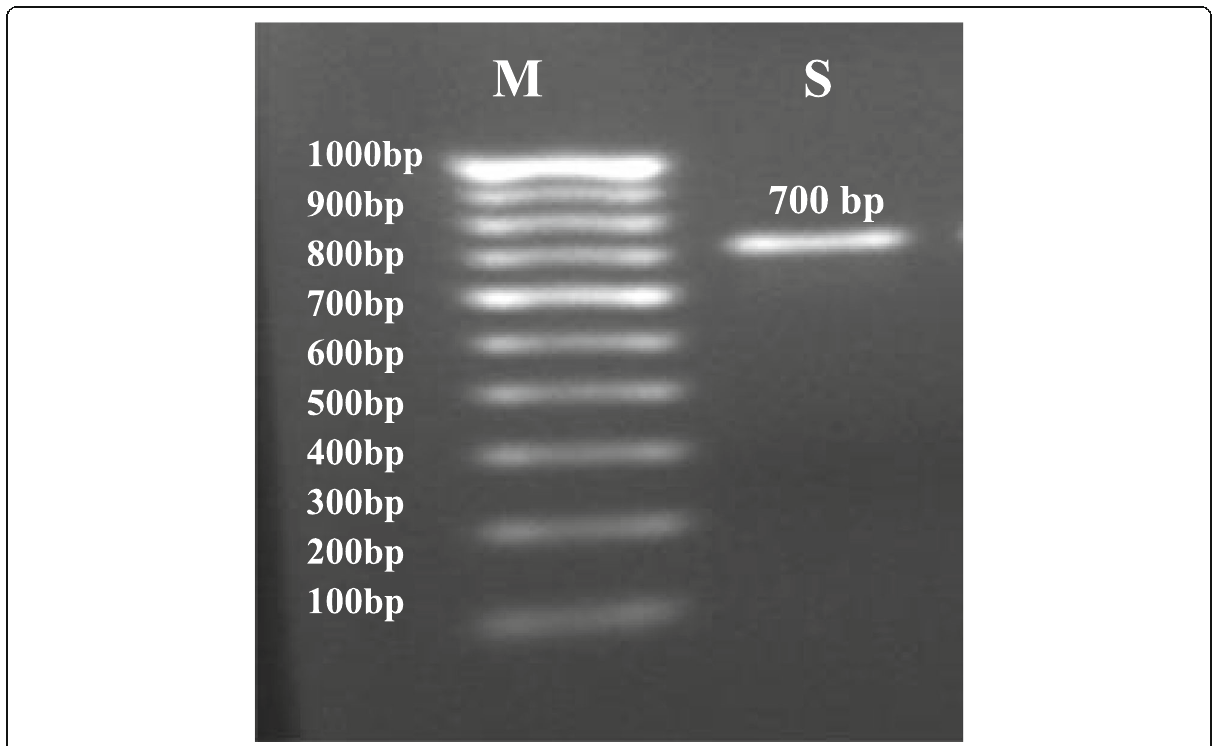
Fig. 3 PCR detection based on polh gene at 700 bp (M, Marker (M):100 bp ladder, S, Spilosoma obliqua polh NPV gene